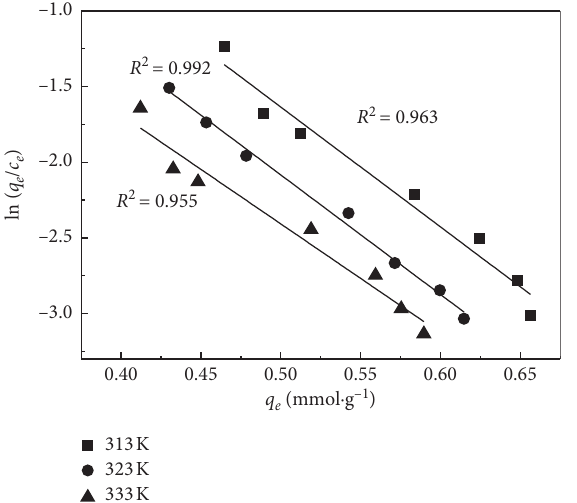
Figure 17: Intraparticle diffusion plots for removal of DBTonto Mn/AC (model oil with different c AC; adsorption temperature, 313K).